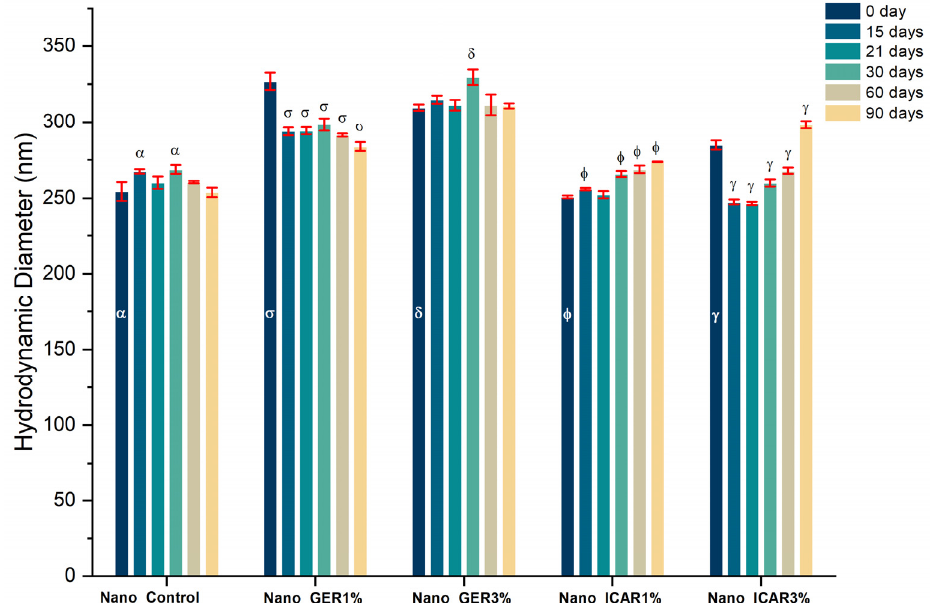
Figure 2. Hydrodynamic diameter (size) of polymeric nanocapsules containing geraniol and icaridin as a function of time (90 days). Measurements were performed in triplicate ( n = 3); these values represent the mean of the three determinations. Considered significance of p < 0.05 (one-way ANOVA—Tukey) for the analysis of variance of times (15, 21, 30, 60, and 90 days) in relation to time 0. Equal symbols ( α , σ , δ , Φ and γ ) represent significant variation.